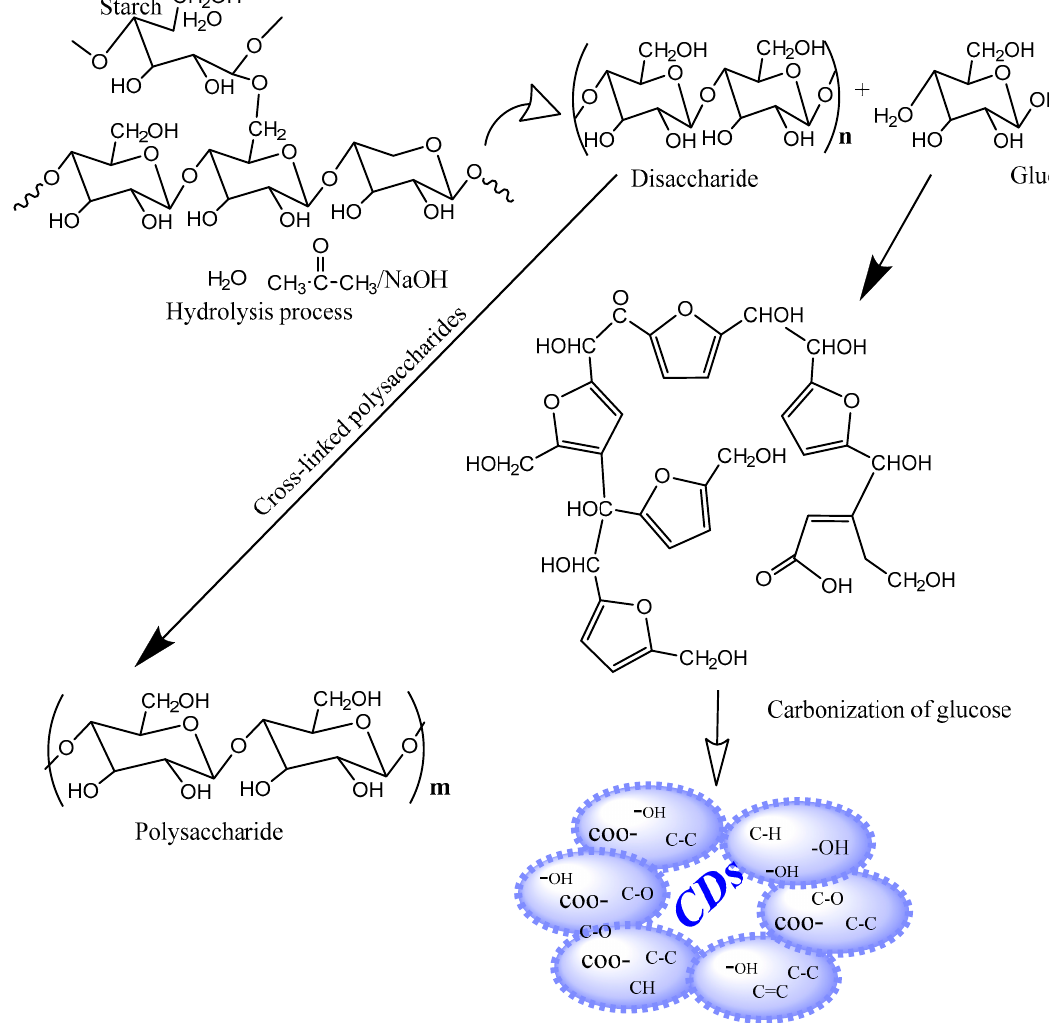
Figure 3. Mechanism for synthesis of carbon dots.